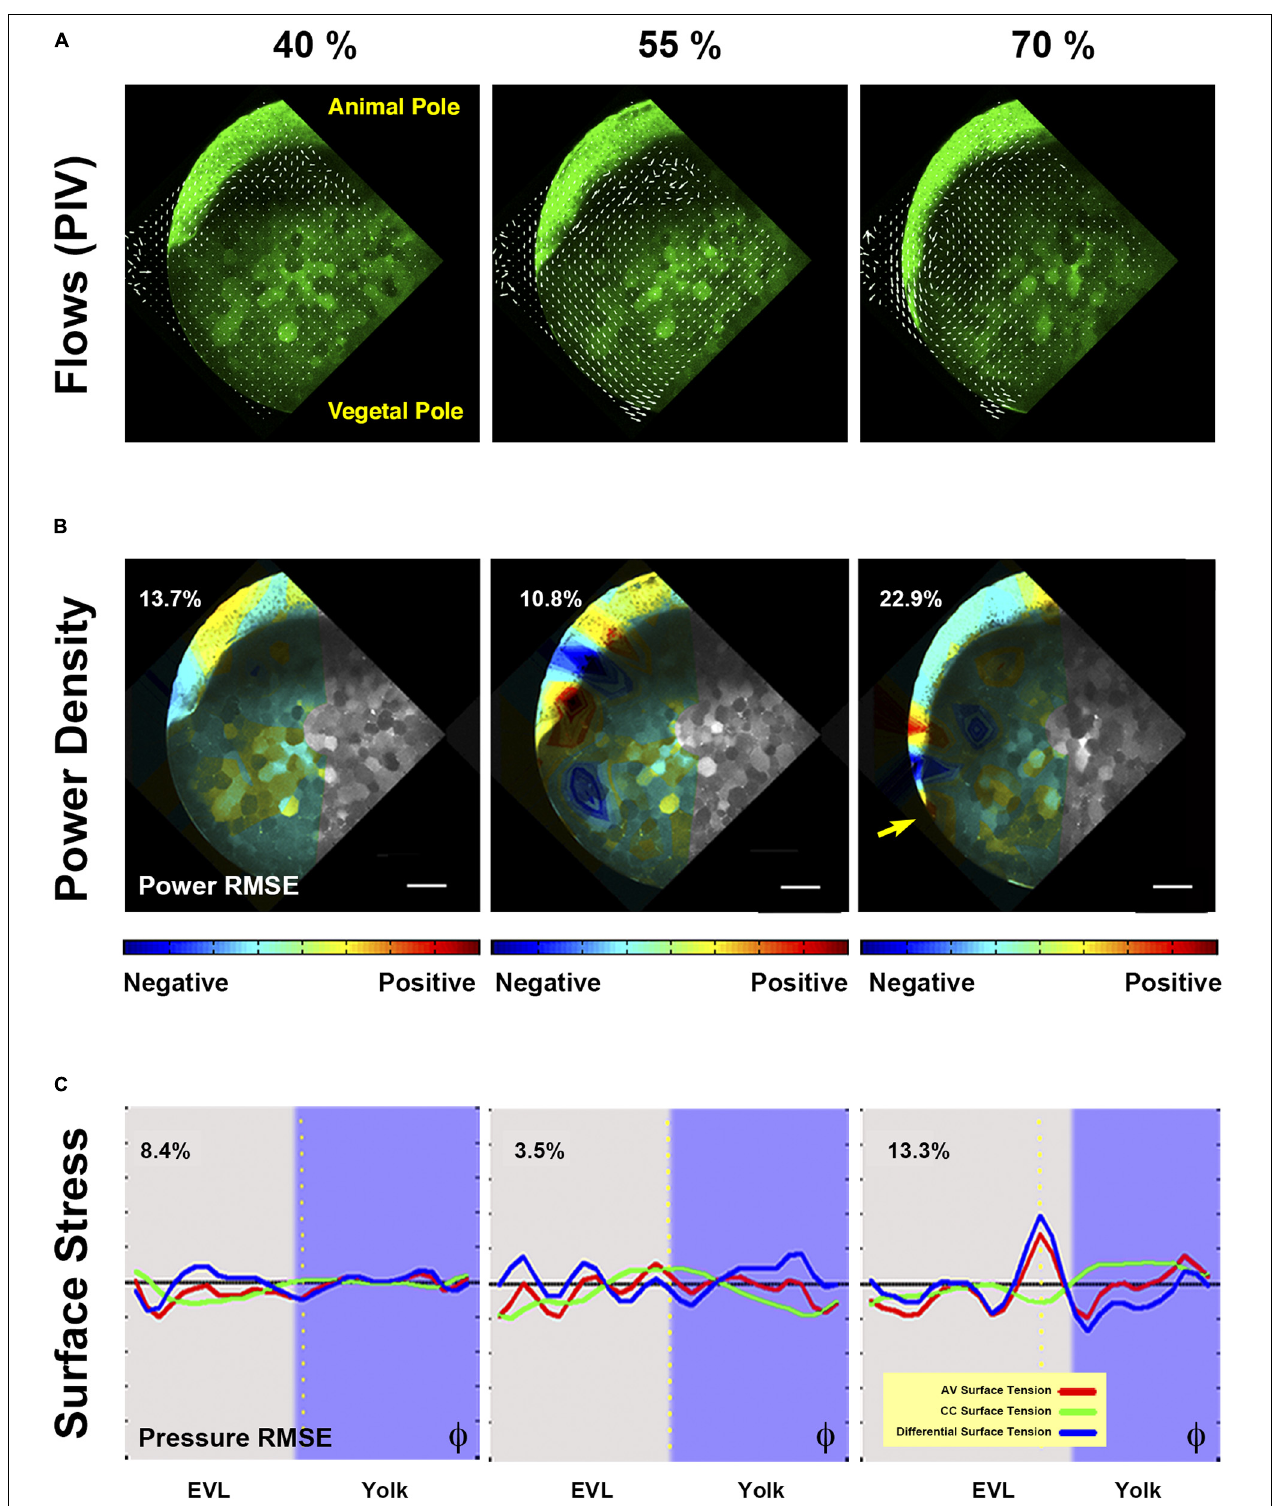
FIGURE 4 | Biomechanics of yolk cell endocytosis impaired embryos. (A) Yolk granules flows patterns are altered in rab5ab YMOs. PIV of time-lapse snapshots imaged by two-photon microscopy of a Tg ( β - actin:m-GFP ) rab5ab YMO (see Supplementary Movies 8, 9 ). From epiboly onset, yolk granules flows are uncoordinated in rab5ab YMOs. The internal toroidal vortices characteristic of epiboly progression (Hernandez-Vega et al., 2017) do not form or are severely reduced